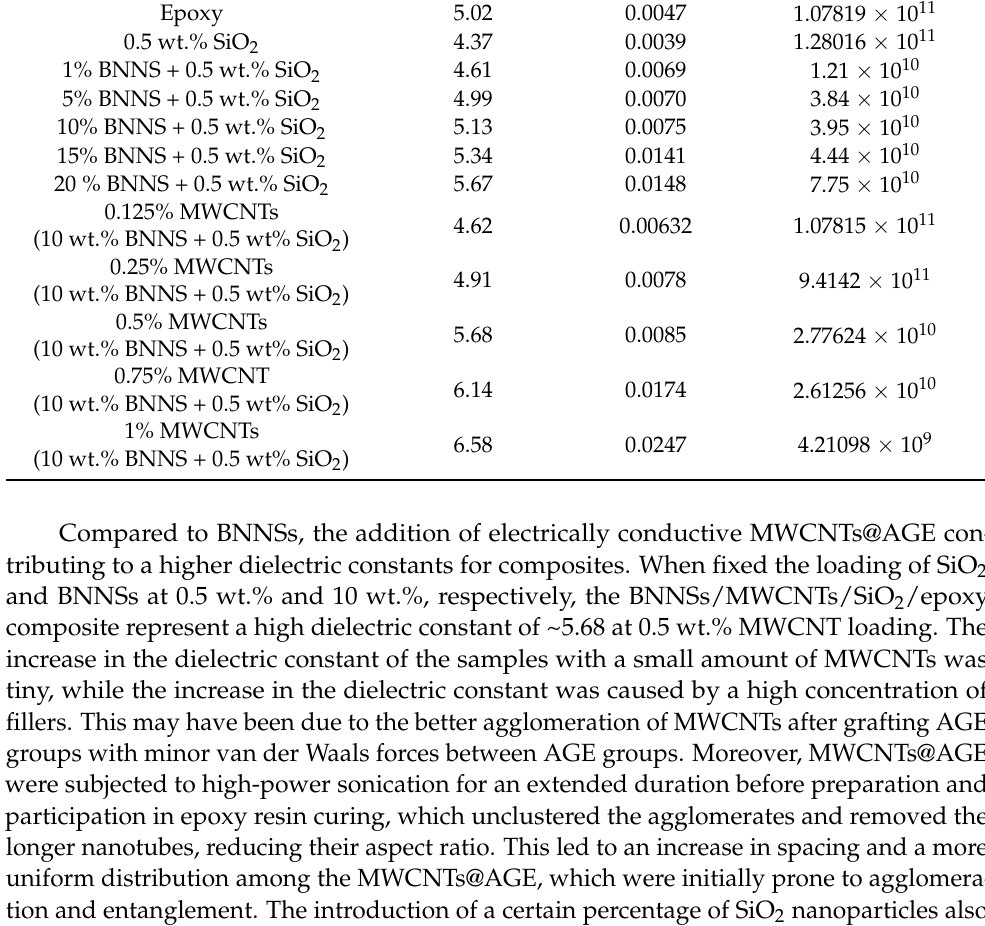
Dielectric Dielectric Volume Constant Loss